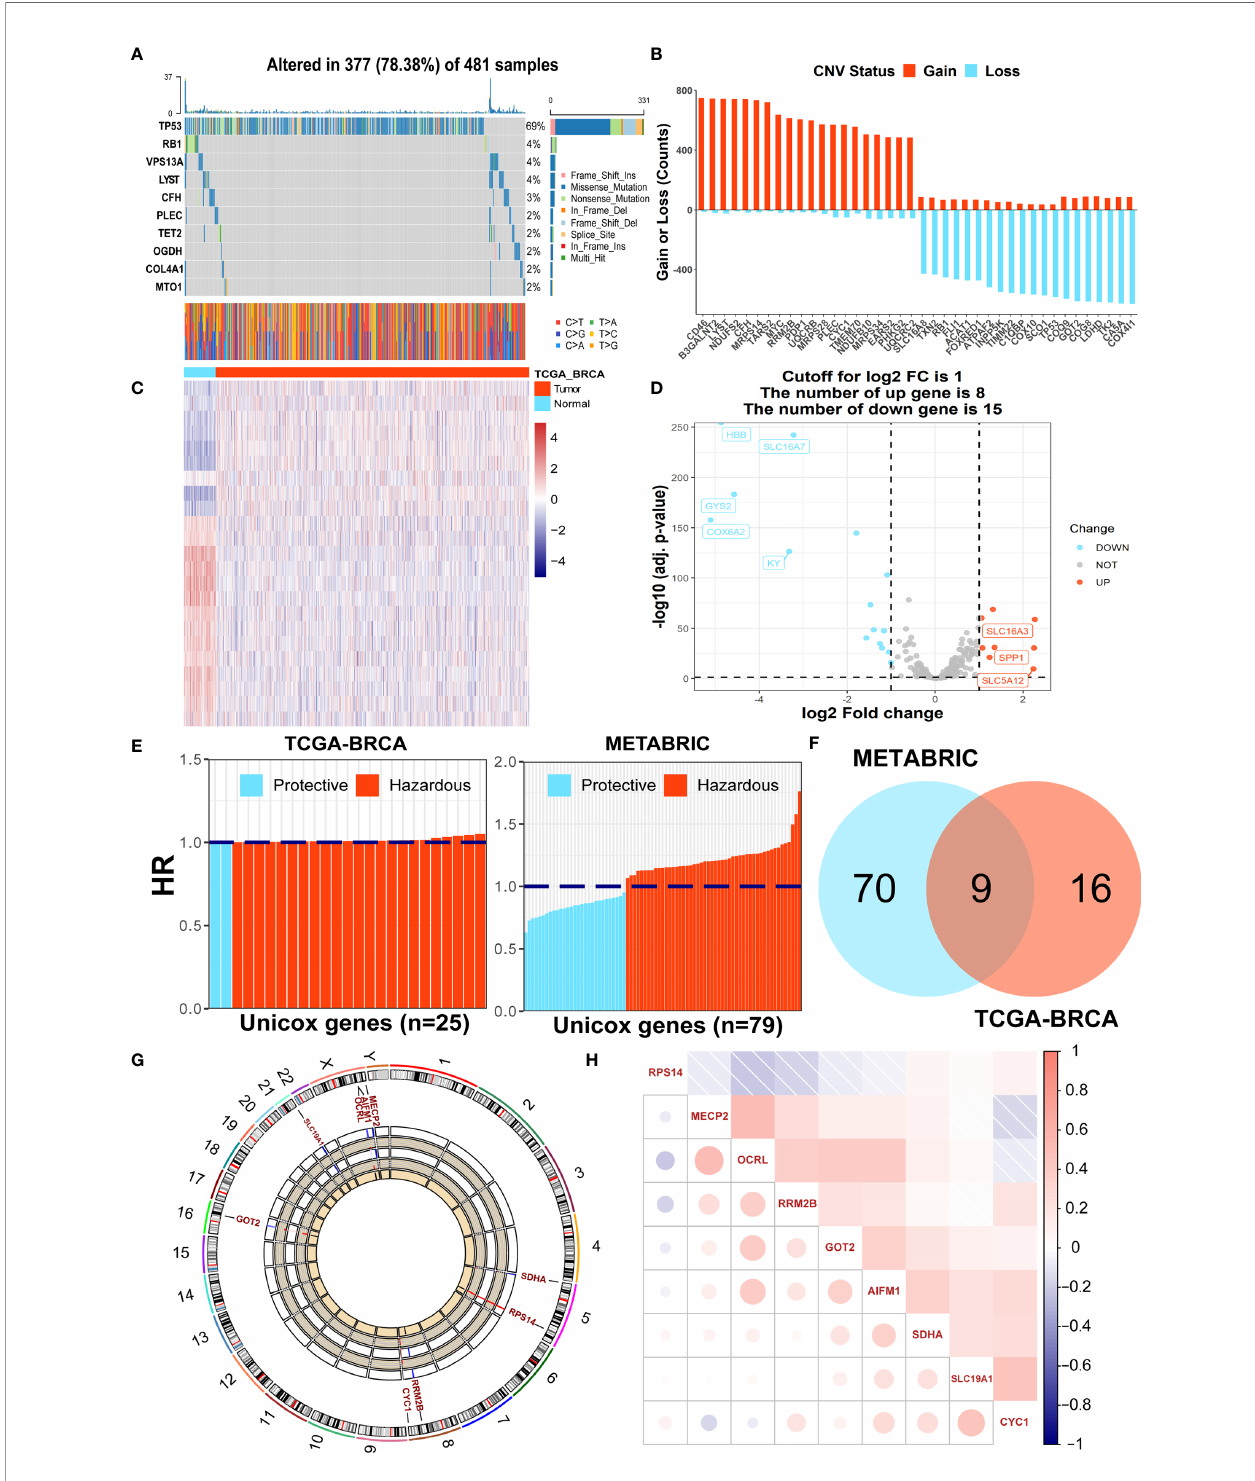
FIGURE 1 | Identi fi cation of prognostic LMGs in BC patients. (A) The somatic mutation frequency of LMGs in the TCGA-BRCA cohort. (B) The prevalent CNV frequency of LMGs in the TCGA-BRCA cohort. (C) Heatmap of differentially expressed genes among LMGs. (D) Volcano plot exhibiting DEGs in LMGs. (E) OS- related LMGs in TCGA-BRCA and METABRIC datasets, respectively. (F) The Veen diagram to detect 9 common prognostic LMGs. (G) The Circos plot illustrating the locations on chromosomes and expression levels of the 9 candidate LMGs. (H) The correlation matrix plot containing 9 prognostic